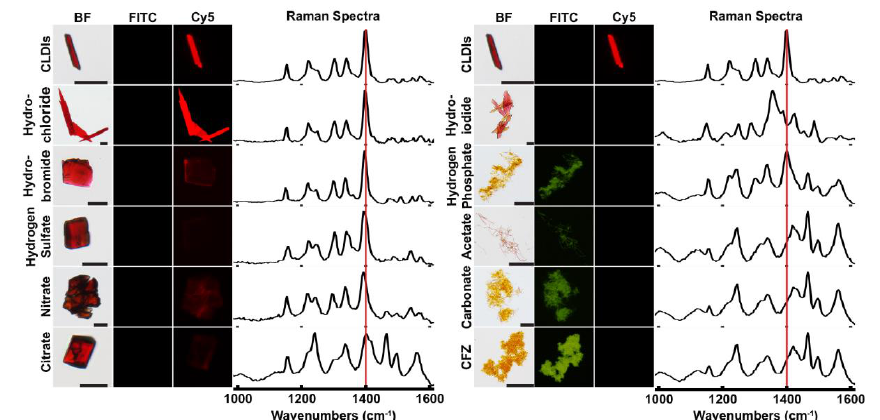
Figure 1. Single crystal Raman micro-spectroscopy spectra and brightfield (BF)/fluorescent (FITC, Cy5) microscopy images of various synthesized clofazimine (CFZ) salts compared to crystal-like drug inclusions (CLDIs) and CFZ free base. The red line represents the signature peak of CLDIs at 1400 cm −1 . Scale bar = 20 µm.